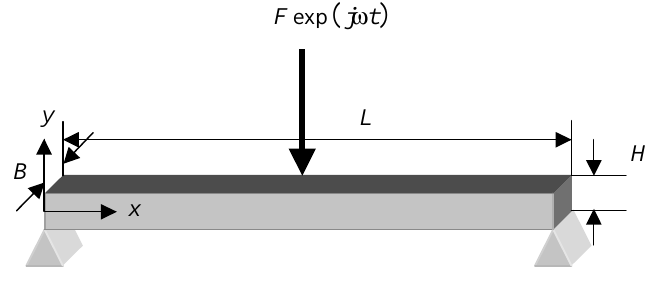
Fig. 3. Simply supported, transversely vibrating Timoshenko beam excited by a harmonic point